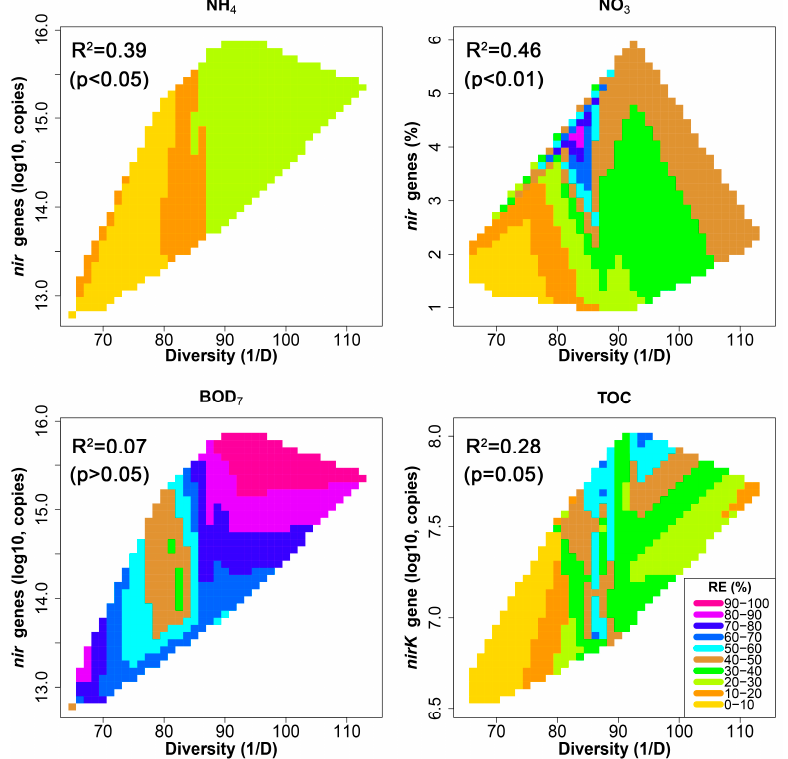
Figure 4. Contour plots showing relationships between the removal efficiency of ammonia, nitrate, BOD 7 , TOC and the diversity of bacterial community and the abundance of nir genes. Adjusted values of variation described ( R 2 ) for the removal efficiency by bacterial community diversity and abundance of nir genes are shown on each